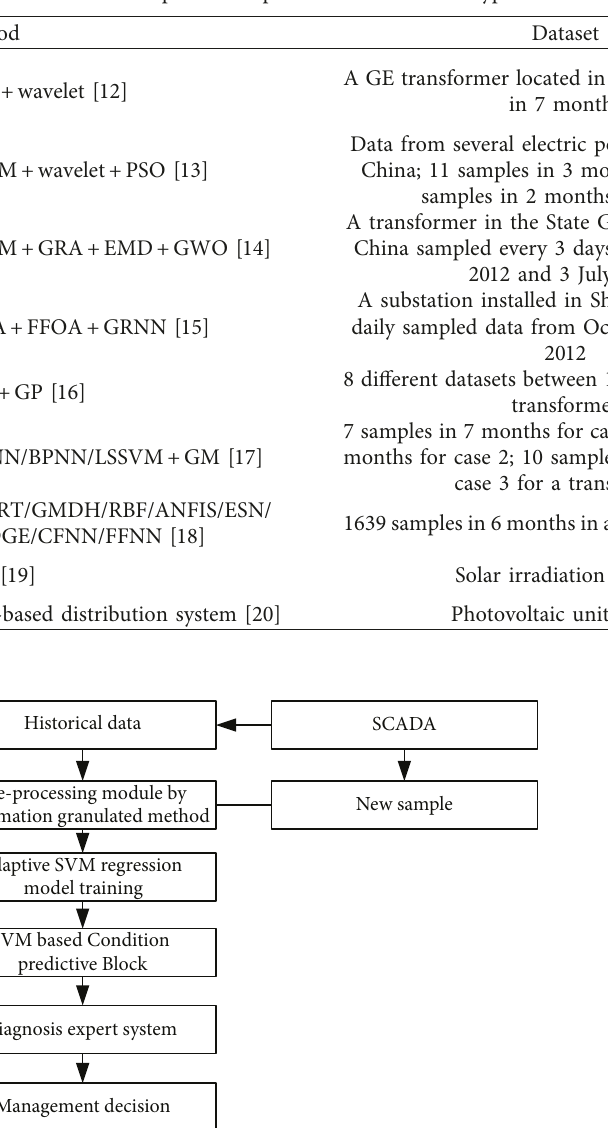
Figure 1: AMS framework for main transformer maintenance management.